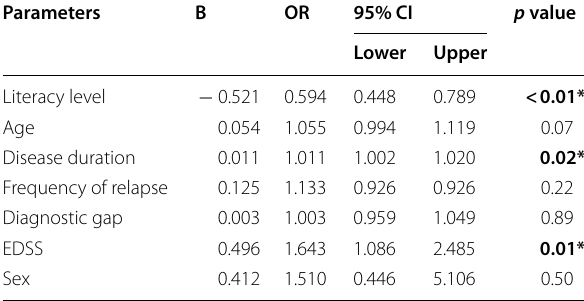
EDSS expanded disability status scale, OR odds ratio, CI confidence interval